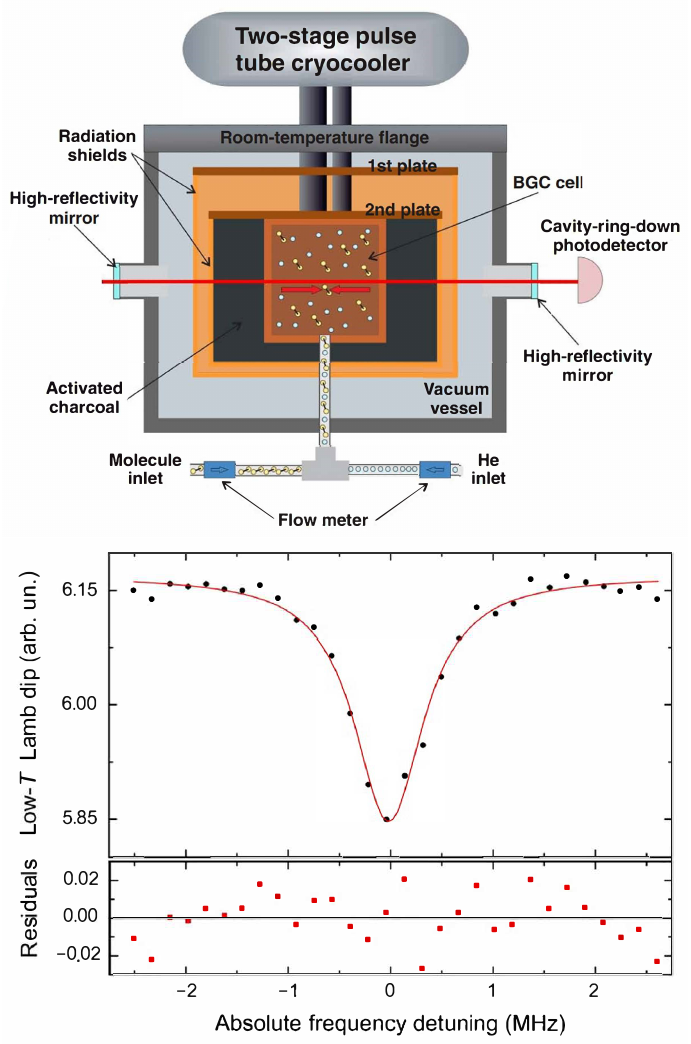
Figure 6. (upper) OFC-assited saturated-absorption cavity ring-down (SCAR) spectroscopy setup for Lamb-dip ro-vibrational measurements on buffer-gas-cooled molecular samples. (lower) Lamb-dip line shape corresponding to a C 2 H 2 sample of (cid:39) 20 K, exhibiting a saturation contrast around 8% and a signal-to-noise ratio around 30, obtained for injection fluxes of 6 (helium) and 6 (acetylene) SCCM. Reprinted with permission from [115] © The Optical